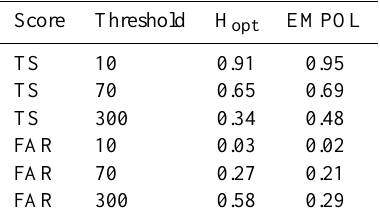
Table 4. Threat Score (TS) and False Alarm Ratio (FAR) for pollen classes using a single threshold. The threshold is given in pollen per cubic